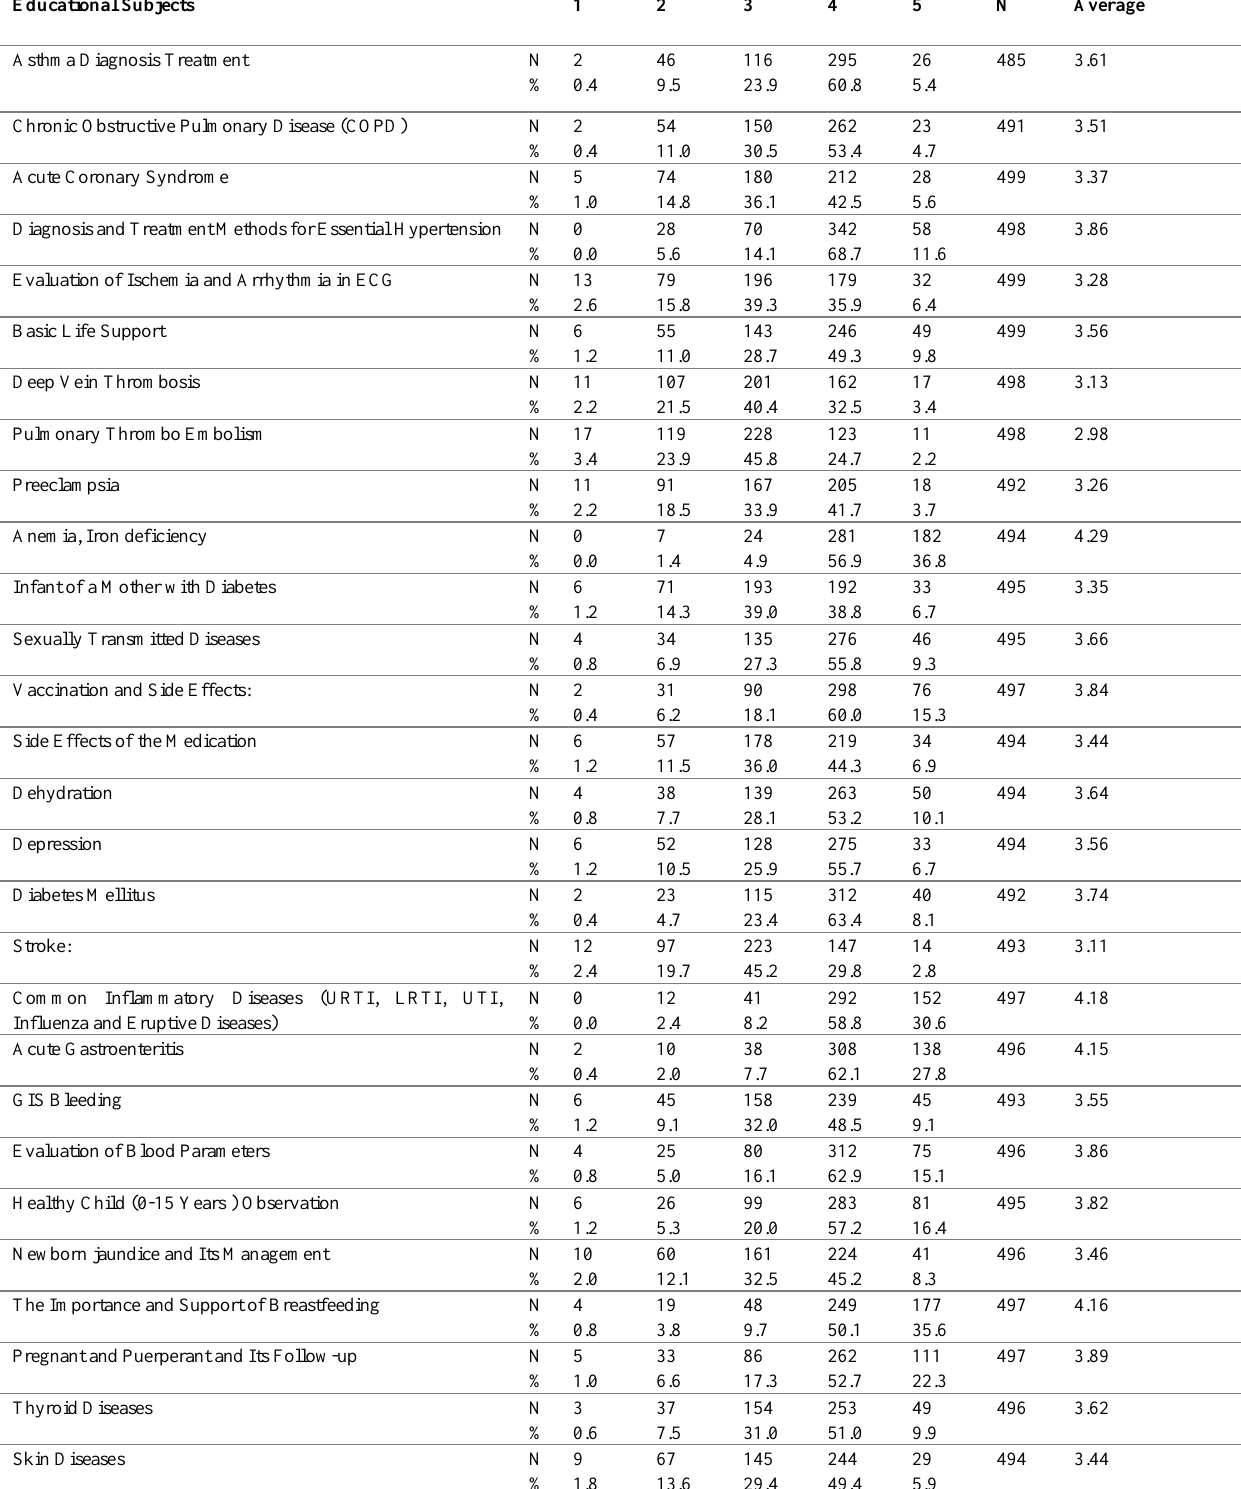
Table 22: Professional Knowledge and Skill Level in Professional